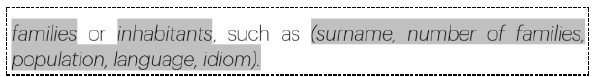
Figure 12. Concepts, relations and properties from ISTAT.